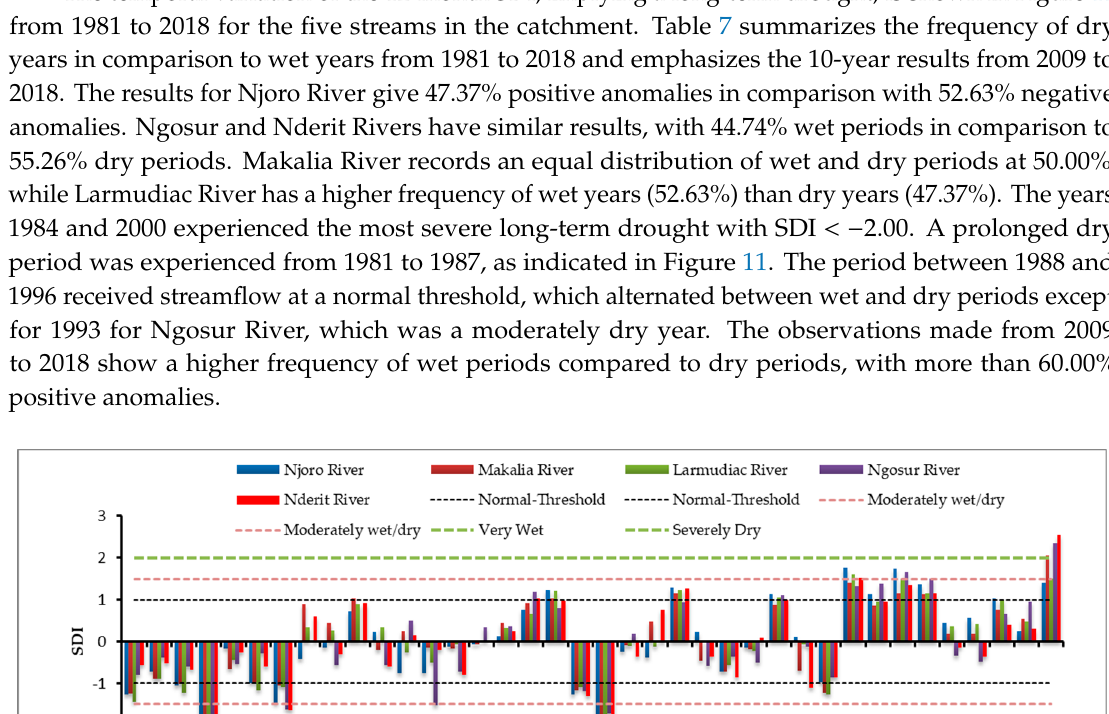
Figure 10. Annual water balance components from 1981 to 2018 for Lake Nakuru Basin.